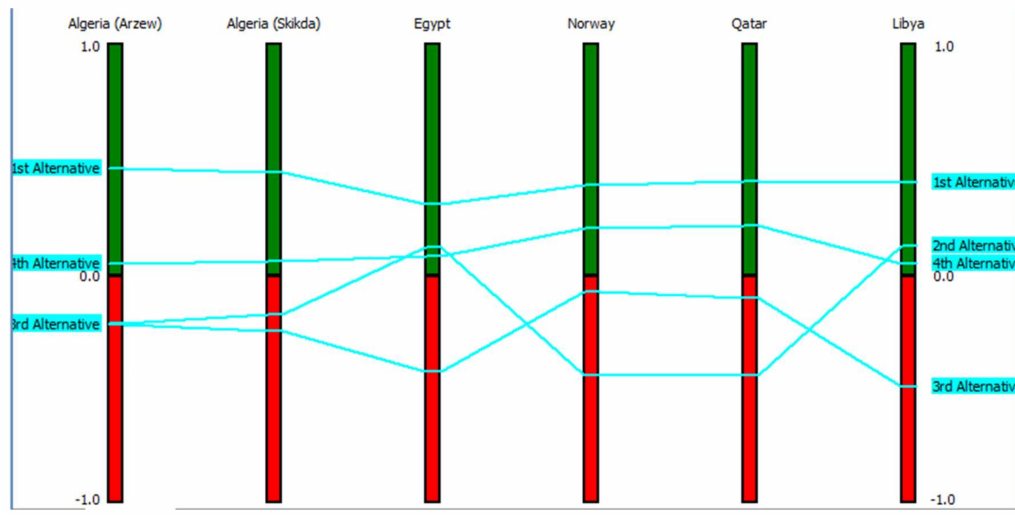
Figure 5. The results obtained from PROMETHEE II for the 1st